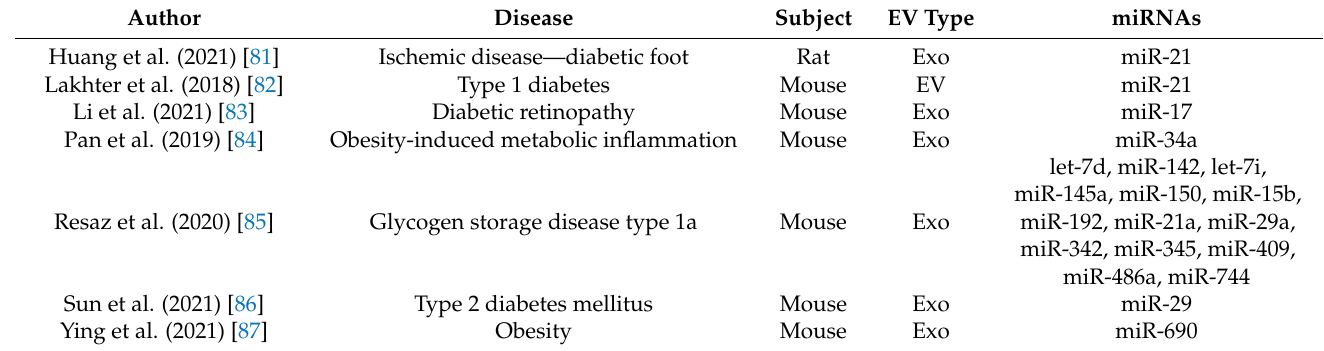
Table 4. Extracellular miRNAs in metabolic